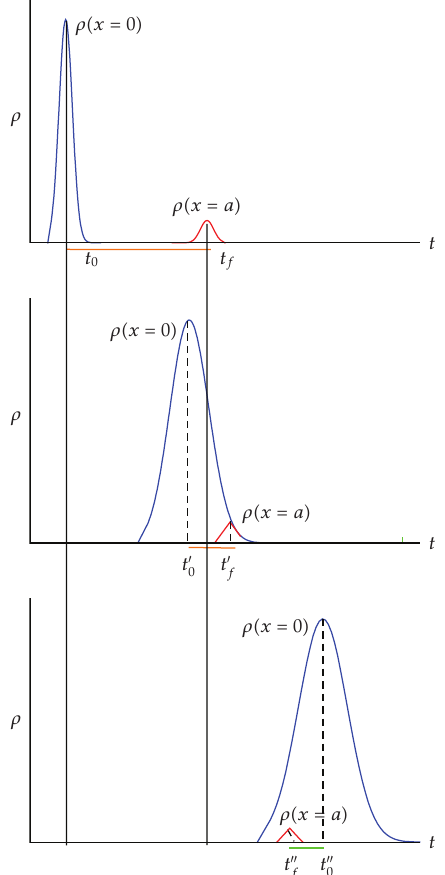
Figure 6: Qualitative description of the time shift between peaks t f , t (cid:5) probability density ρ (cid:2) x (cid:6) a,t (cid:3) and ρ (cid:2) x (cid:6) 0 ,t (cid:3) of a wave